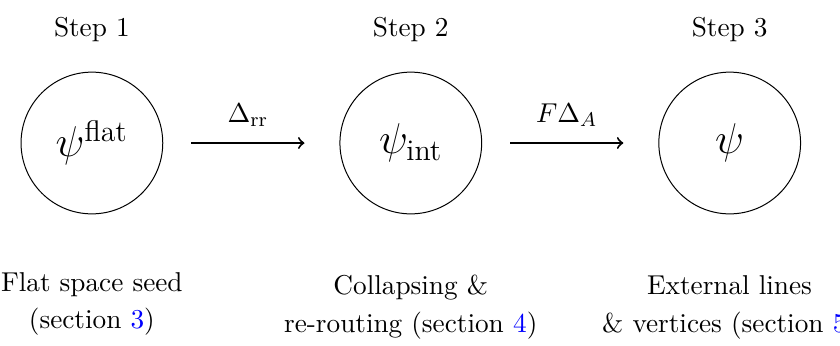
Figure 1 . Depiction of the sequence of differential operators acting on the flat space seed function ψ flat to obtain the function ψ specified by the edges and